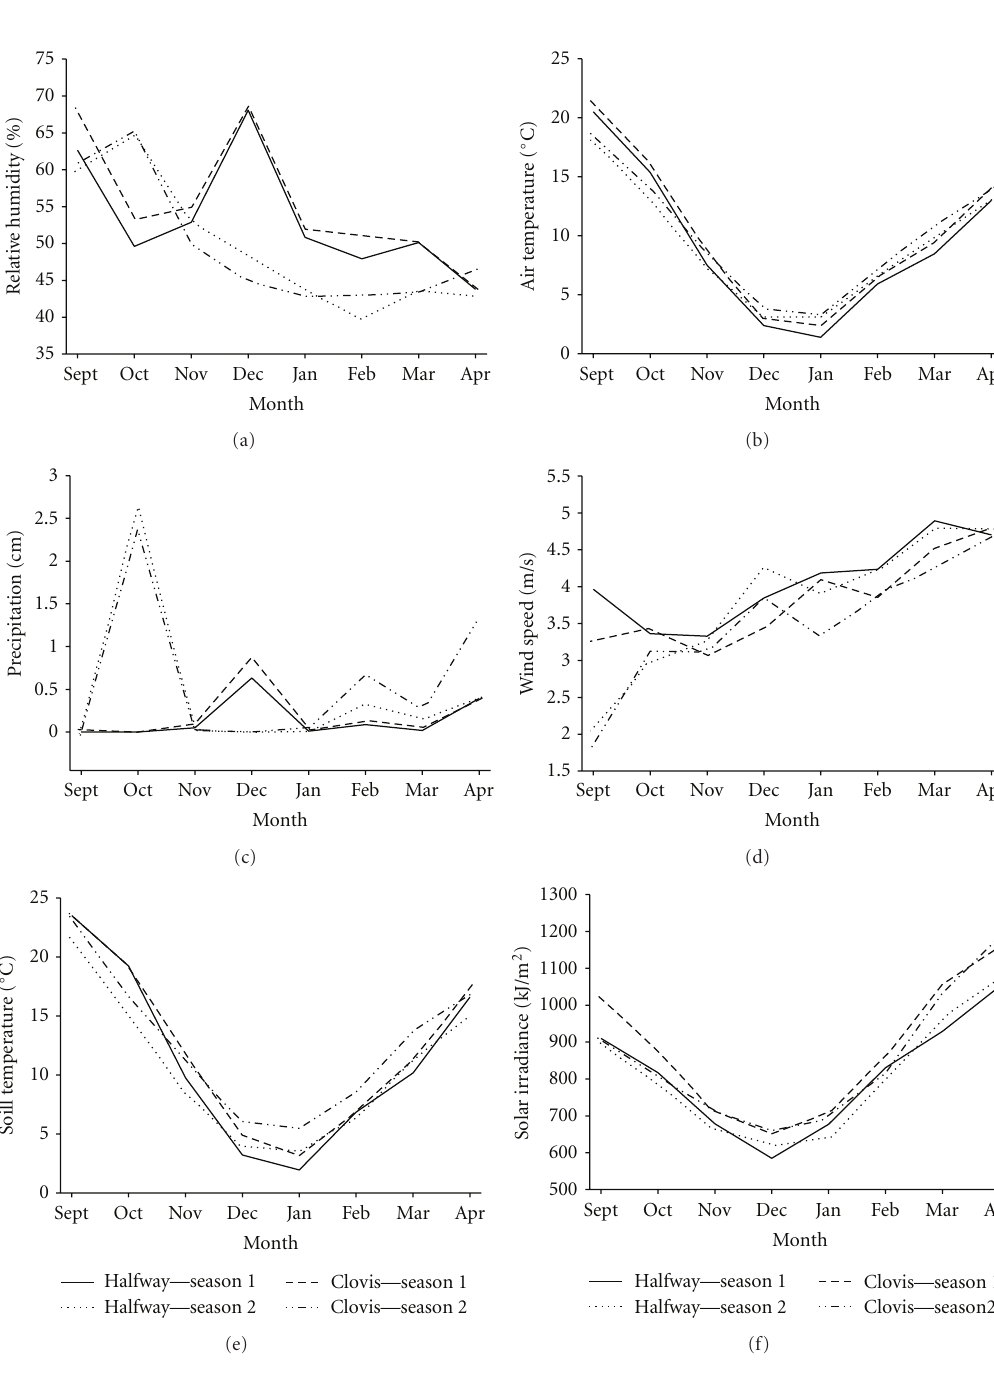
between abiotic conditions and ranked plant weight.